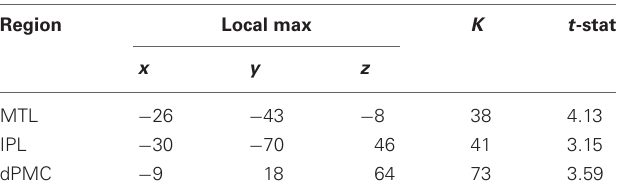
Table 3F | Human-coded enthusiasm, controlling SA rated positive × evaluative.